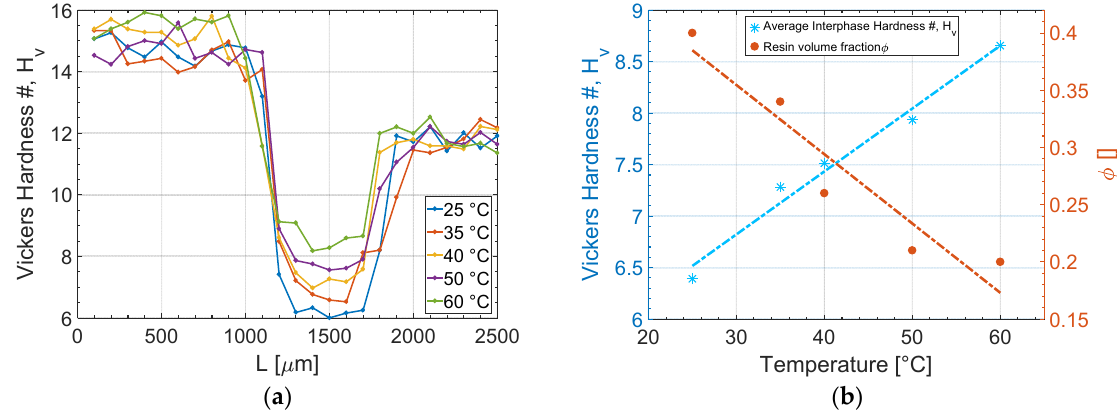
Figure 13. ( a ) Vickers microhardness values at the interphase vicinity for UPR-ABS interphase, and ( b ) correlation between interphase hardness and resin volume fraction.